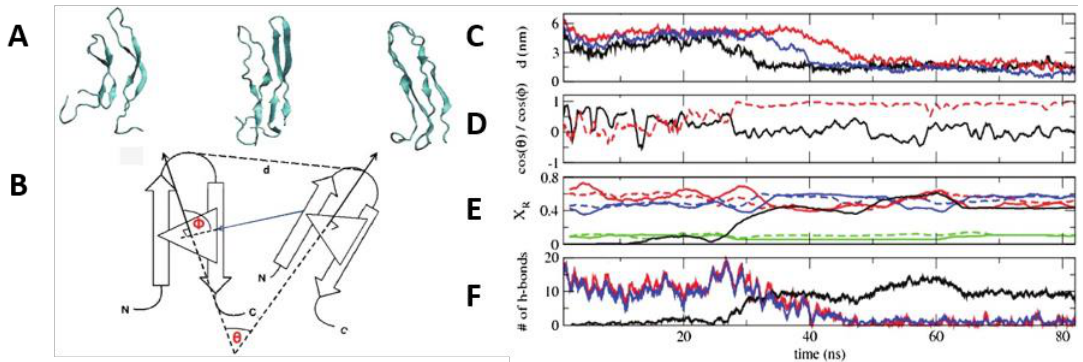
Figure 13. Characterisation of the formation of dimers of hIAPP. ( A ) Representative configurations along the dimerisation pathway of two human amylin peptides in their β-hairpin conformation. The time evolution of the process of dimerisation was characterised, taking the distance between monomers using the turn-forming Asn22 ( B ), the angles between orientation vectors (( C , D ) with schematic representation ( B )) (first, molecules at a distance of 5 nm, with a θ angle between the two peptides of 90° ( D , shown in black); second, molecules at a distance of 6 nm, with a θ angle between them of 180° (shown in red)) in each monomer, secondary structure ( E ), the number of main chain intra-strand hydrogen bonds in the two monomers, and the number of main chain inter-strand hydrogen bonds ( F ). Adapted from Reddy et al. [69]. Copyright (2010) with permission from Elsevier.